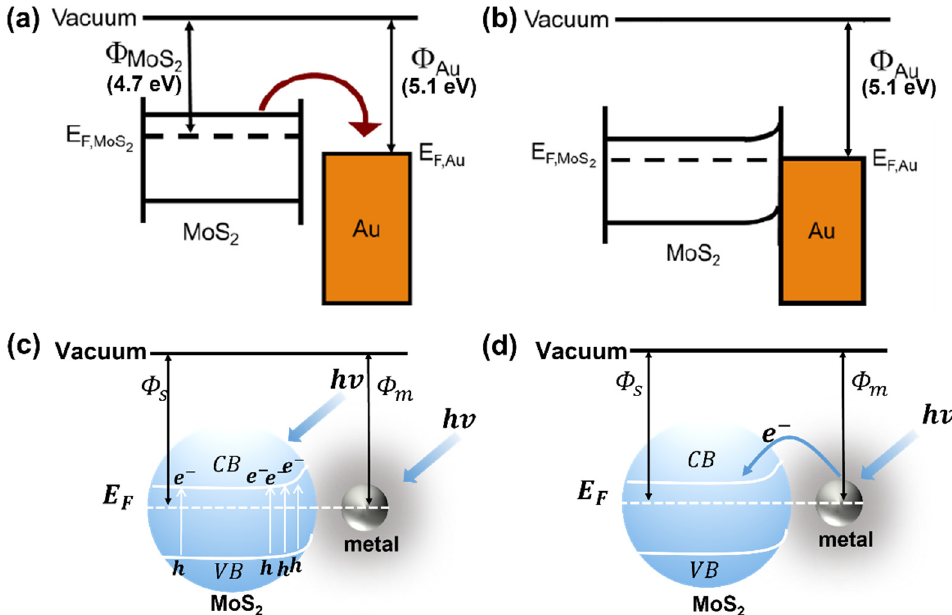
Figure 2. ( a , b ) Schematic diagram of Fermi level movement of Au/MoS 2 hybrid SERS substrate. Reprinted with permission from ref. [48]. Copyright 2014 Springer Nature. ( c ) Mechanism for plasmonic enhancement of light absorption. ( d ) Mechanism for plasmonic sensitization and electron excitation from the metal nanocrystal to MoS 2 .